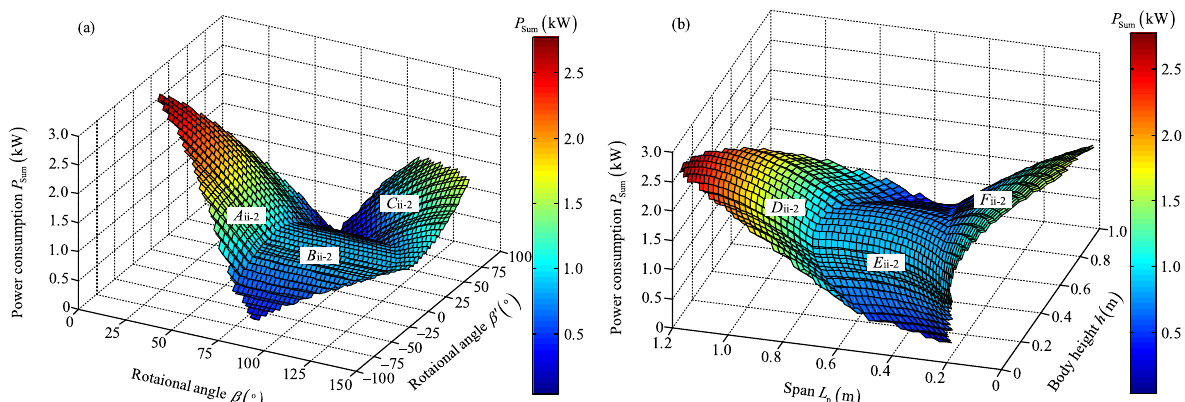
Figure 12 Variable tendency charts of P sum under secondary working conditions ii-2: a With changes in β ′ and β , b with changes in h and L